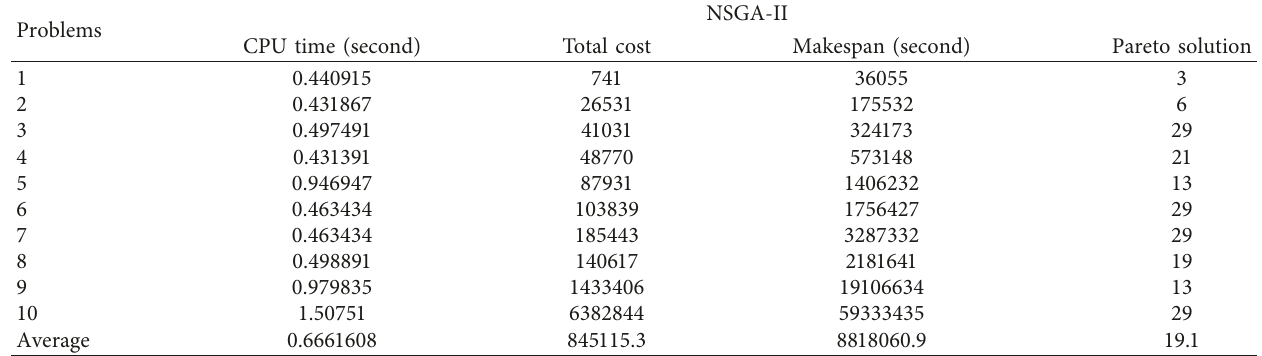
Table 10: Superior performance of each problem based on SAW method for NSGA-II.